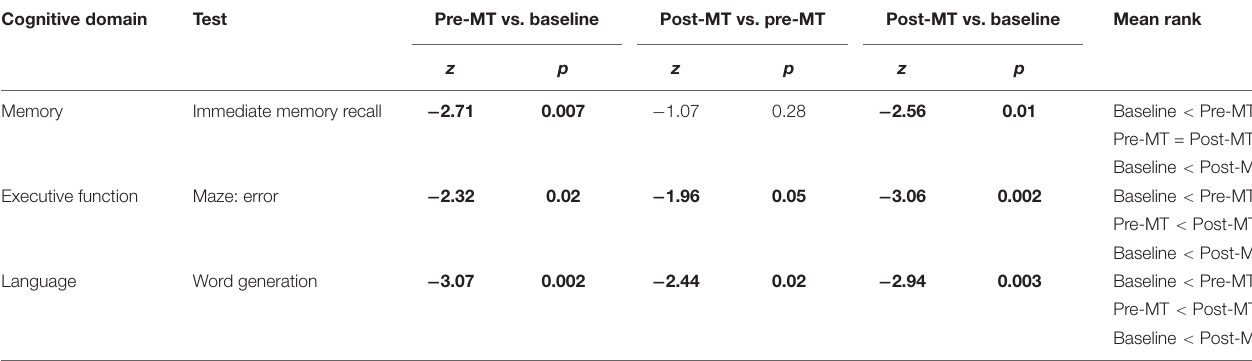
TABLE 2 | A summary of post hoc test results for group one. Cognitive domain